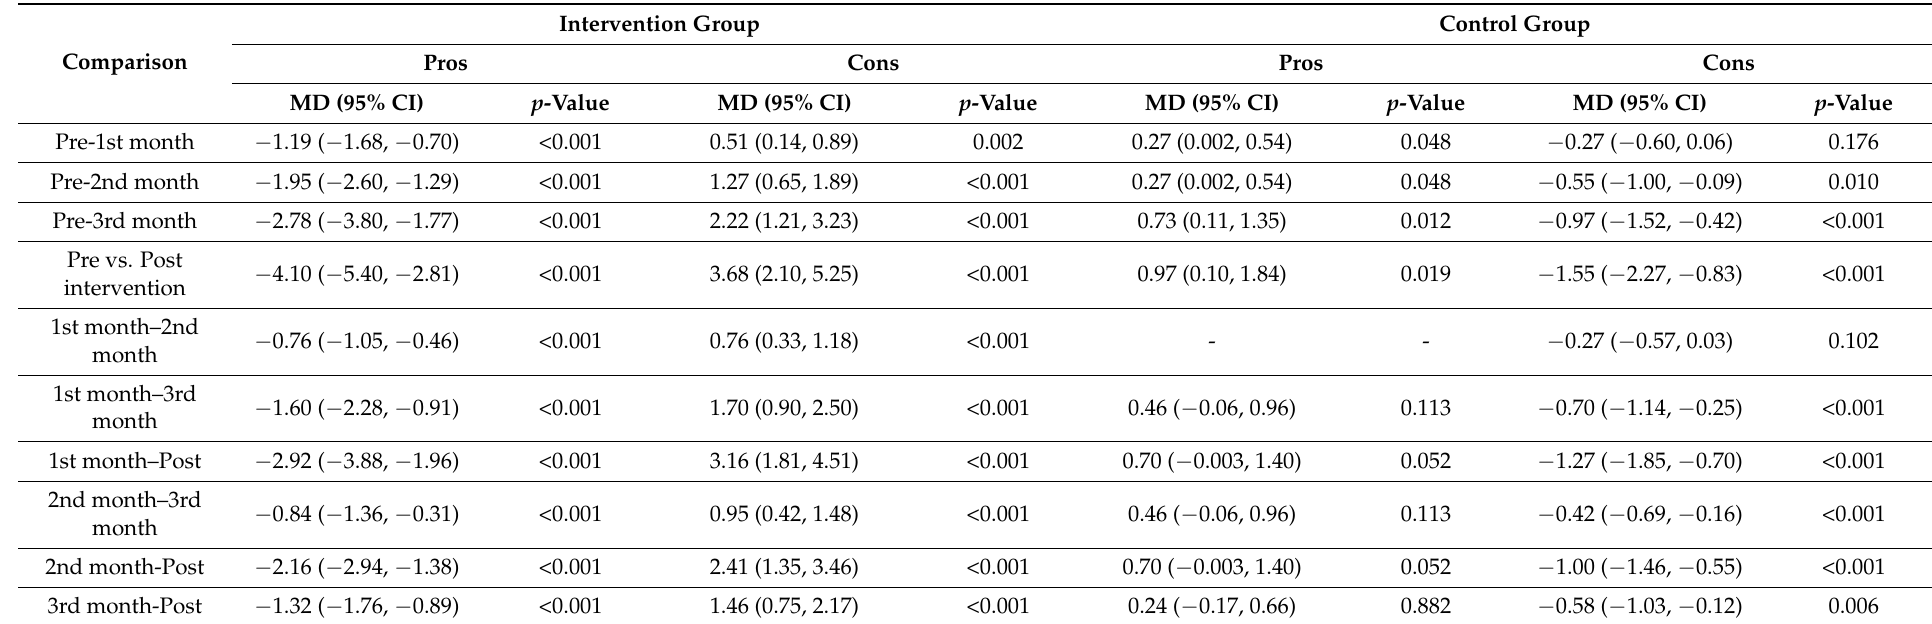
Table 2. Comparison of DB-M score within group based on time (Time